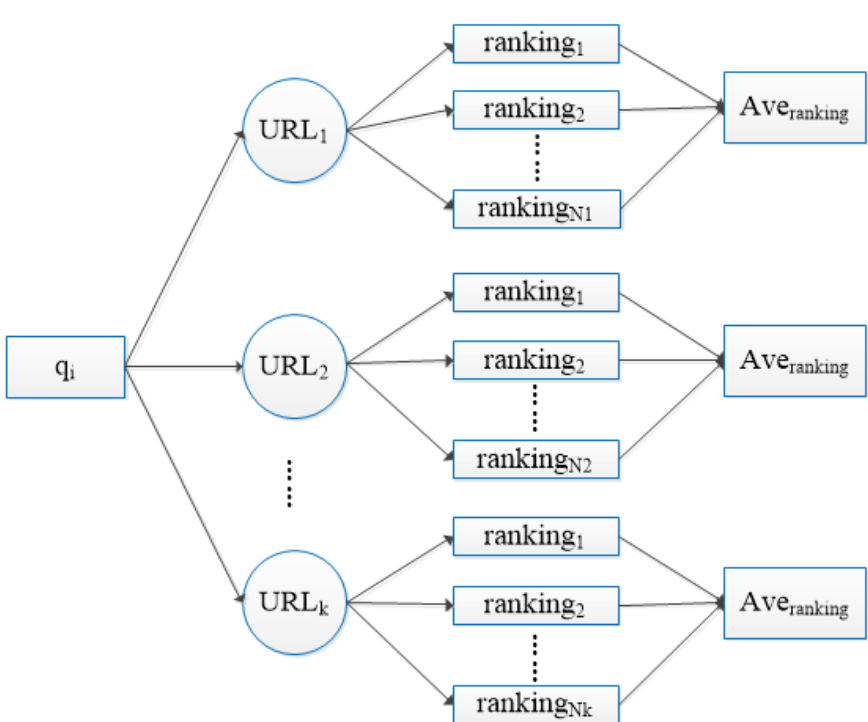
Figure 3. The structure of query, clicked URLs and